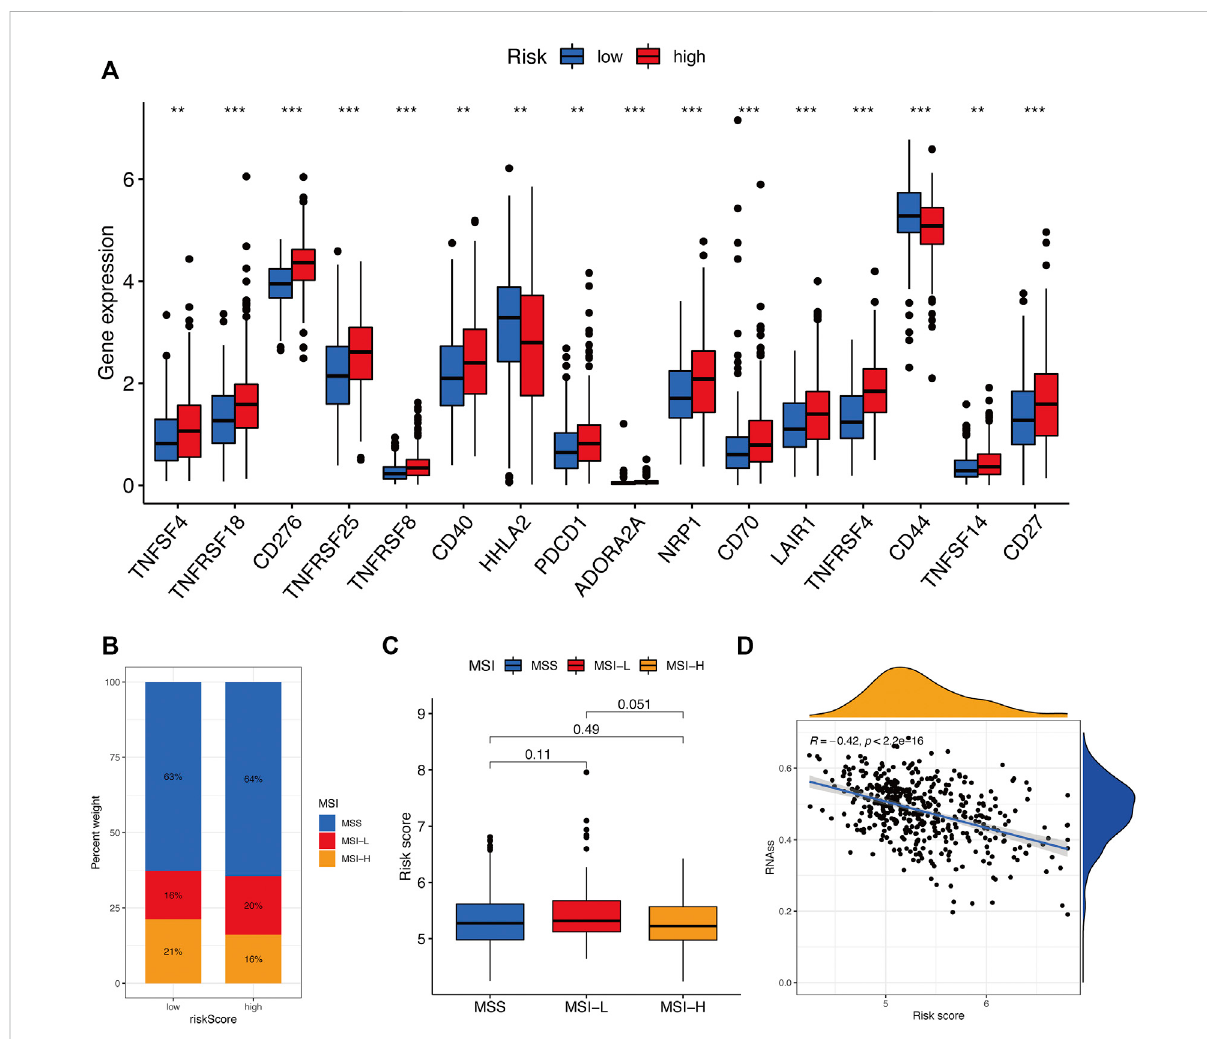
FIGURE 10 Evaluationoftheimmunotherapyresponsebetweentworiskgroups. (A) Immunecheckpointexpressionlevelsbetweenthehigh-andlow-risk groups. (BandC) CorrelationbetweenriskscoreandMSI. (D) Correlation betweenriskscorealongwithCSCindex.ns, p > 0.05.ns,notsigni fi cant;*, p < 0.05; **, p < 0.01; ***, p <